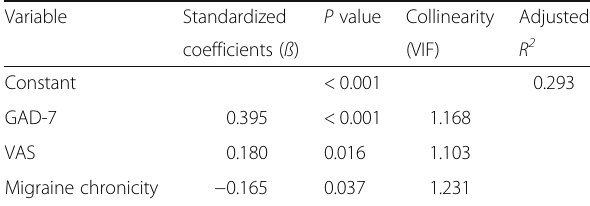
Table 4 Major determinants for the overall AQ score by multivariate analyses in migraine patients Variable